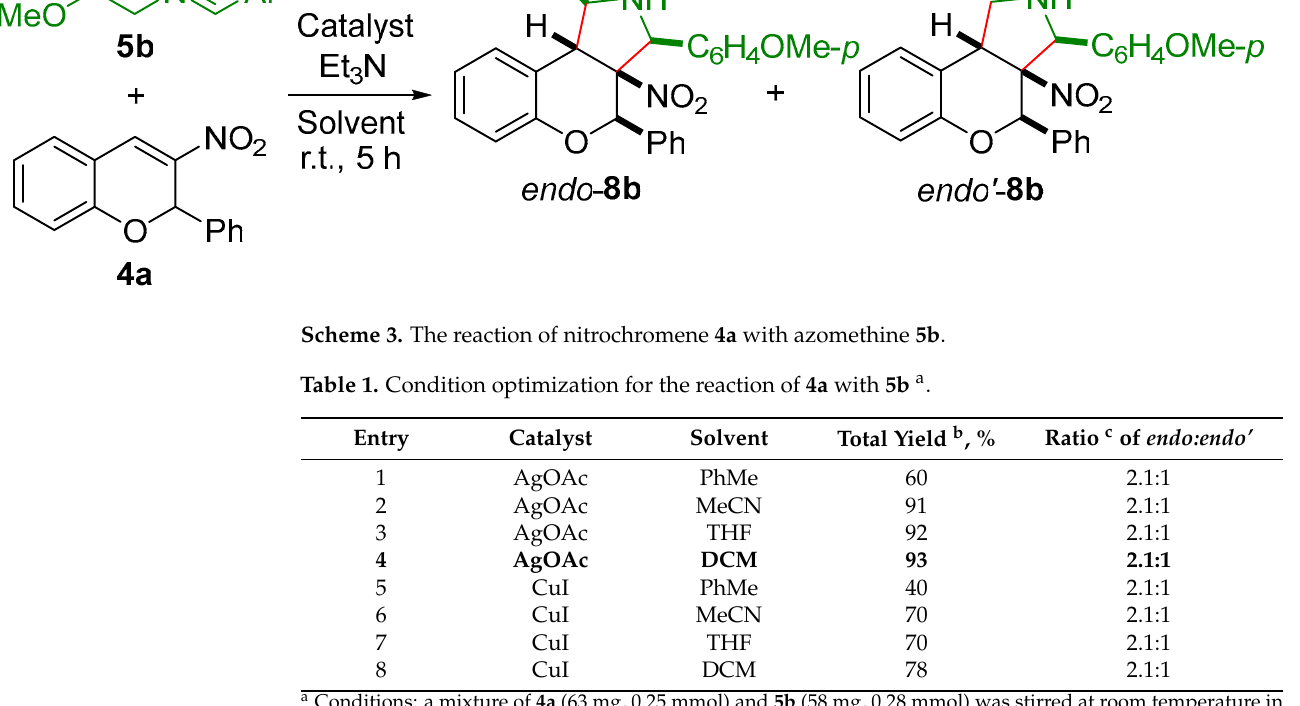
Scheme 3. The reaction of nitrochromene 4a with azomethine 5b . Table 1. Condition optimization for the reaction of 4a with 5b a .